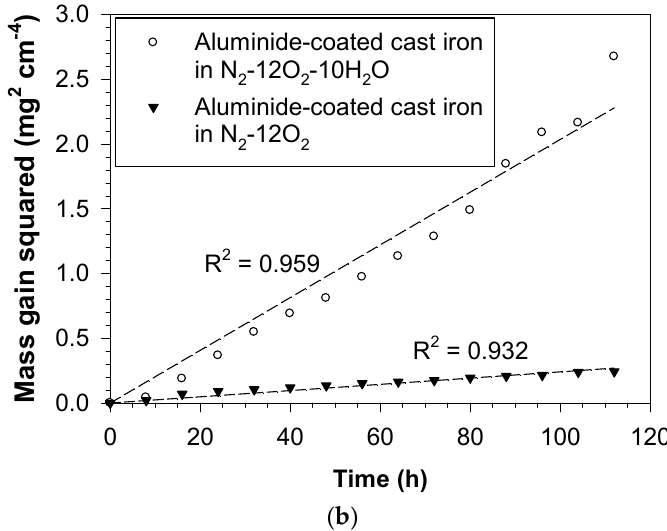
Figure 8. Relationship between the square of mass gain and time for the cyclic oxidation at 850 °C of ( a ) the bare cast iron in N 2 –12O 2 –10H 2 O and ( b ) the aluminide-coated cast irons in N 2 –12O 2 –10H 2 O and in N 2 –12O 2 .